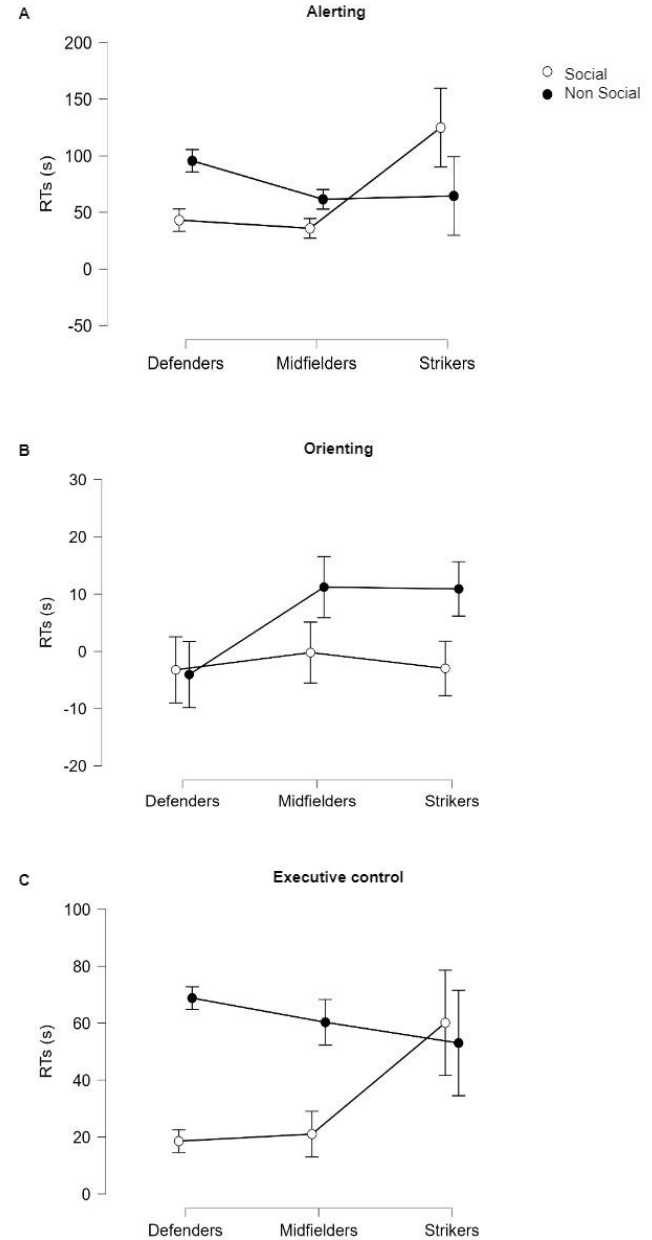
Figure 2. RT variations in ( A ) Alerting (double-cue vs. no-cue conditions); ( B ) Orienting (spatial-cue vs. central-cue conditions); and ( C ) Executive Control (congruent-flanking vs. incongruent-flanking conditions) are reported. On the y-axis RTs (s) and on the x-axis three-level between-factor Roles (Strikers, Midfielders, and Defenders) and two-level within-factor Stimuli (Social and Non-Social) are reported with separate lines. Abbreviations: RTs = reaction-time variations.